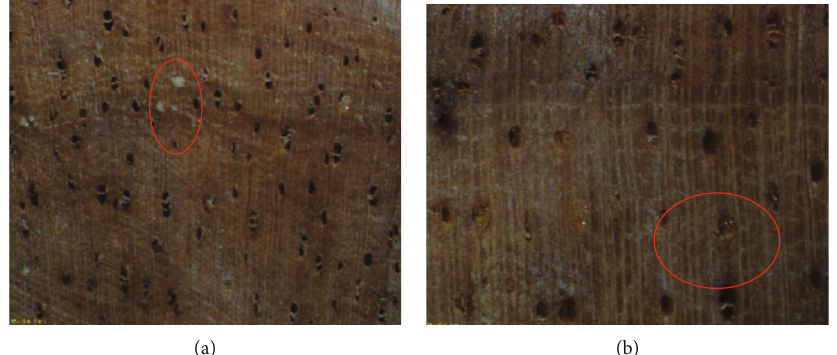
Figure 6: Photomicrographs of control and 25% MUG resin-treated wood at the transverse section. (a, b) Control and 25% MUG resin- treated wood.